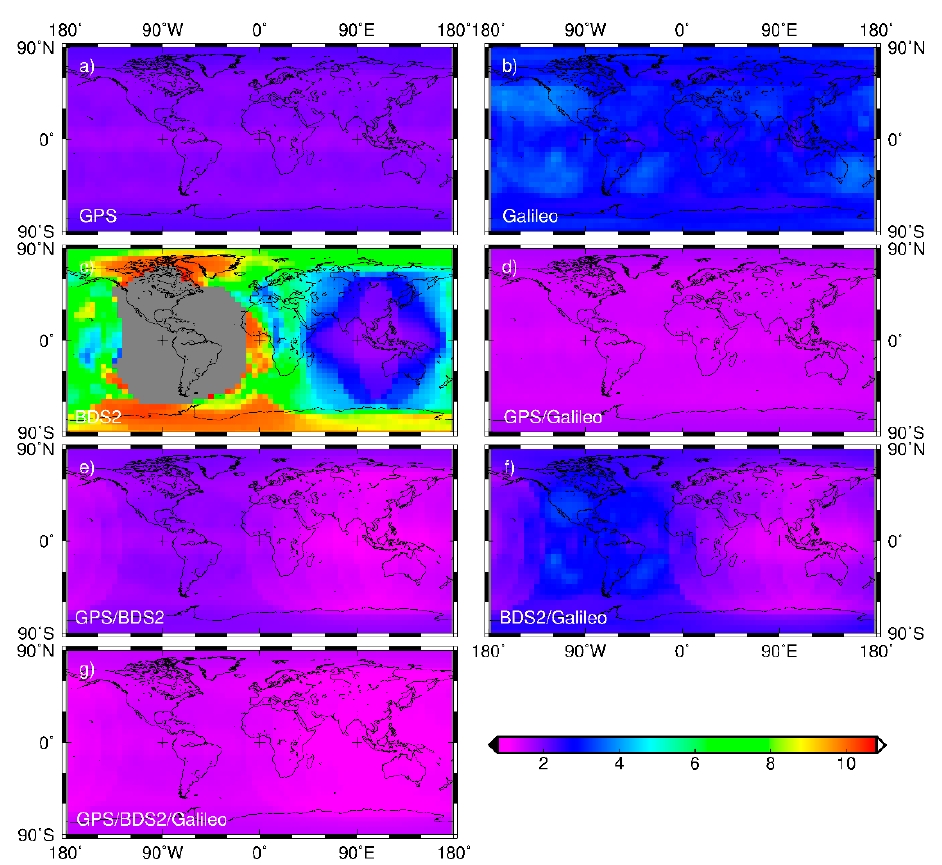
Figure 9. Global distribution of the satellite PDOP values for seven different constellation combinations on DOY 321, 2018.